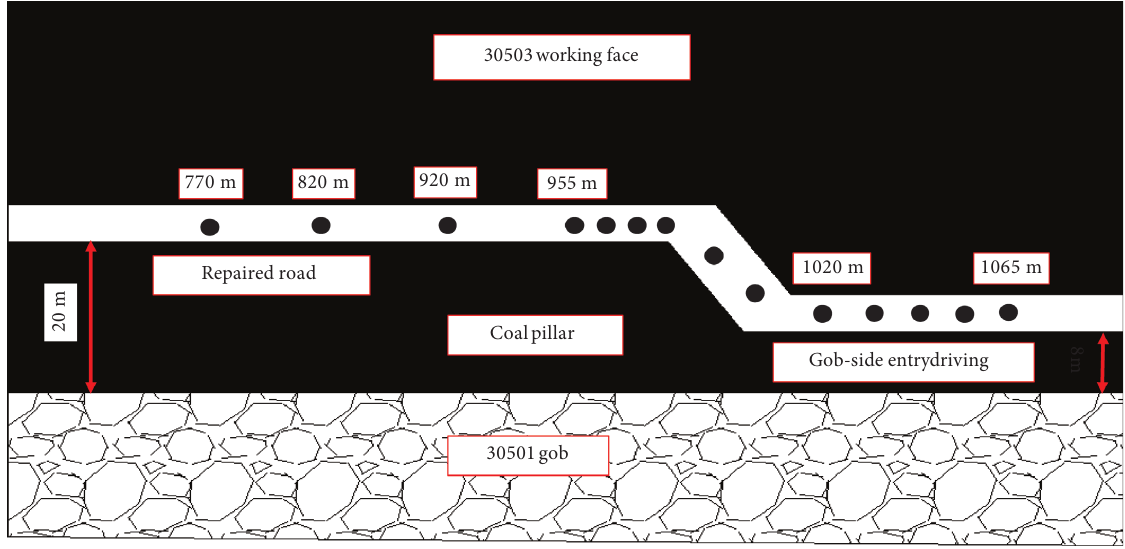
Figure 13: Schematic diagram of roadway deformation monitoring points.